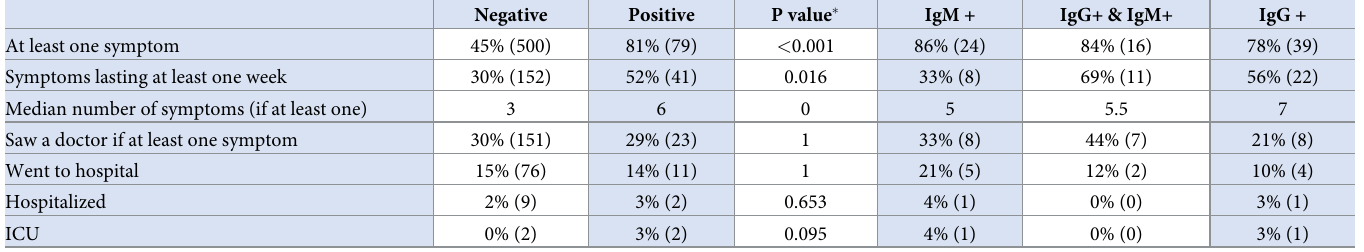
Table 2. Characteristics of symptoms associated with COVID-19 and health seeking behaviour by seropositivity and results of the rapid diagnostic test BIOSYNEX COVID-19 BSS, Dagahaley refugee camp, Garisa County, Kenya, May